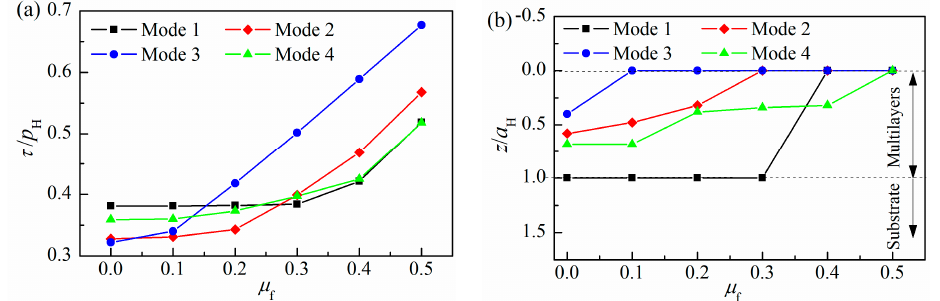
Figure 5. The peak value of the maximum shear stress τ / p H and its depth of multilayered coatings with different elasticity modulus changing modes under various friction coefficients, ( a ) the peak value of the maximum shear stress, ( b ) the depth of the peak of the maximum shear stress. Figure 6 is the stress σ xx along z axis of multilayered coatings with different elasticity modulus changing modes when the friction coefficient μ f is 0. Actually, the stress σ xx along z axis of each elasticity modulus changing mode is the same under various friction coefficient, since the stress σ xx in the x ‐ o ‐ z plane caused by tangential traction applied on the surface is asymmetrical at the two sides of z axis. It can be observed that the stress σ xx along z axis is markedly different for multilayered coatings with different elasticity modulus changing mode. For mode 1, which represents a homogeneous hard coating, the stress component σ xx is tensile in the region close to the substrate and the maximum tensile stress σ xx located at the bottom of the coating reaches up to about 0.48 p H , which is closely related to the cracks initiated at the bottom of the coating. For mode 2 to mode 4, which represent various multilayered hard coatings with gradient structural layout, the stress σ xx is tensile too in the region close to the substrate, however the maximum tensile stress σ xx is much smaller than that of mode 1, and the maximum tensile stress σ xx decreases successively in the order of mode 4, mode 2 to mode 3. Figure 6. The stress σ xx along z axis of multilayered coatings with different elasticity modulus changing modes when friction coefficients μ f is 0. Figure 7 is the stress σ xx along x axis of multilayered coatings with different elasticity modulus changing modes under various friction coefficients. The stress σ xx along x axis is tensile at the tail ‐ edge of loading area under various friction coefficients, which is believed to be responsible to the cracks initiated on the surface. The tensile stress σ xx at the tail ‐ edge of the loading area increases with the increase of friction coefficient [8,10,11], while the maximum tensile stress σ xx at the tail ‐ edge not only depends on the friction coefficient but also strongly depends on the elasticity modulus changing mode of multilayered system. As indicated in Figure 7, the maximum tensile stress σ xx at the tail ‐ edge of loading area decreases in the order of mode 3, mode 2, mode 4 to mode 1 under various friction coefficients, and the maximum tensile stress σ xx at the tail ‐ edge of mode 4 is almost the same to that of mode 1. Under relatively small friction coefficient such as 0 and 0.1, the maximum tensile stress at